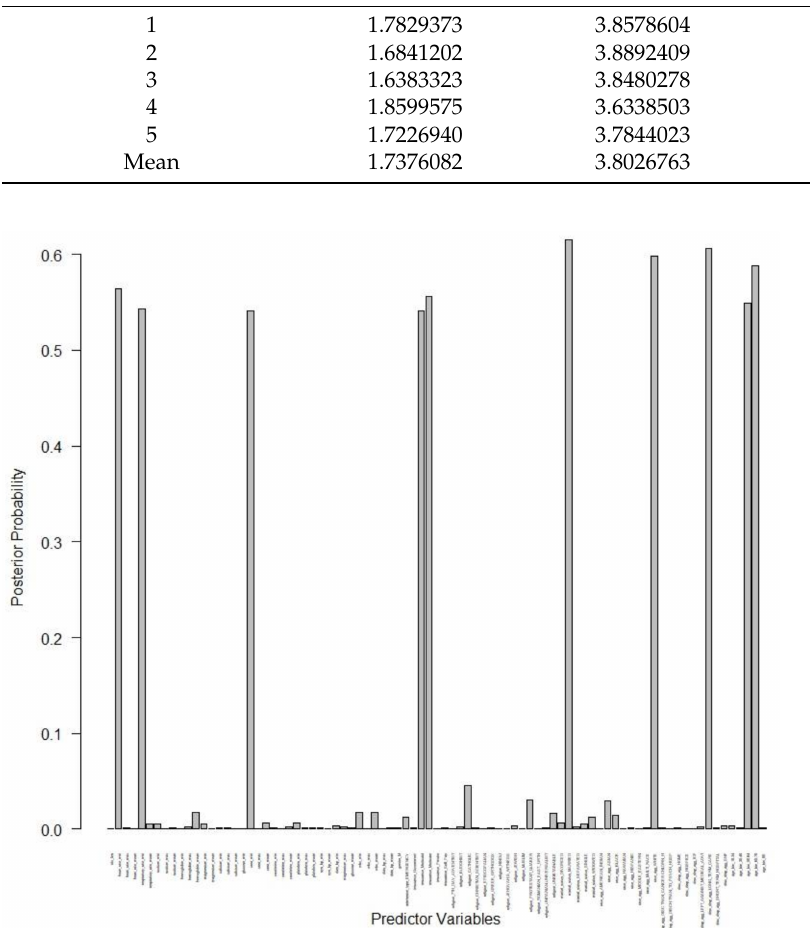
Figure 5. Posterior probability plot for the 30-day hospital readmission